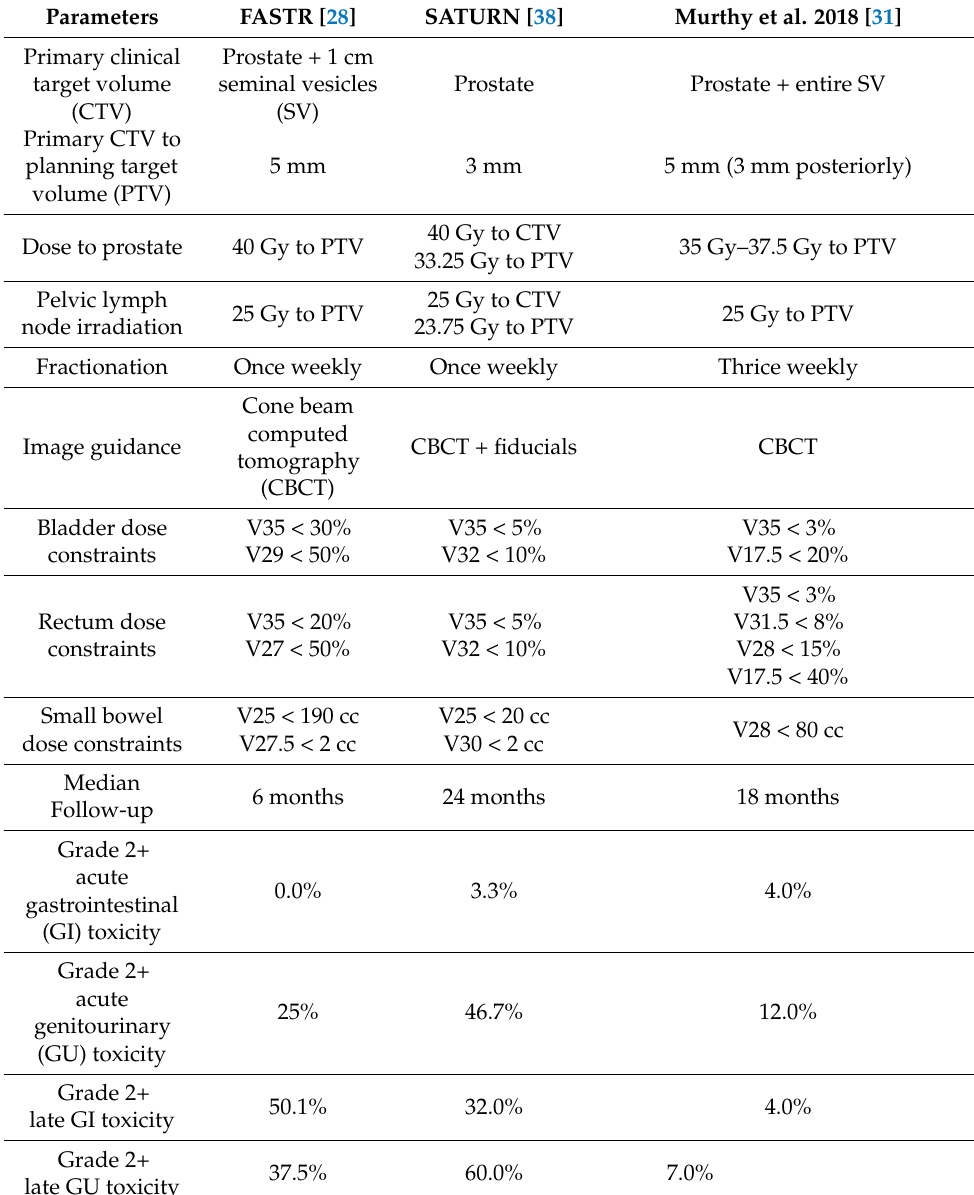
Table 2. Treatment characteristics and observed toxicities of the three trials that included pelvic lymph node